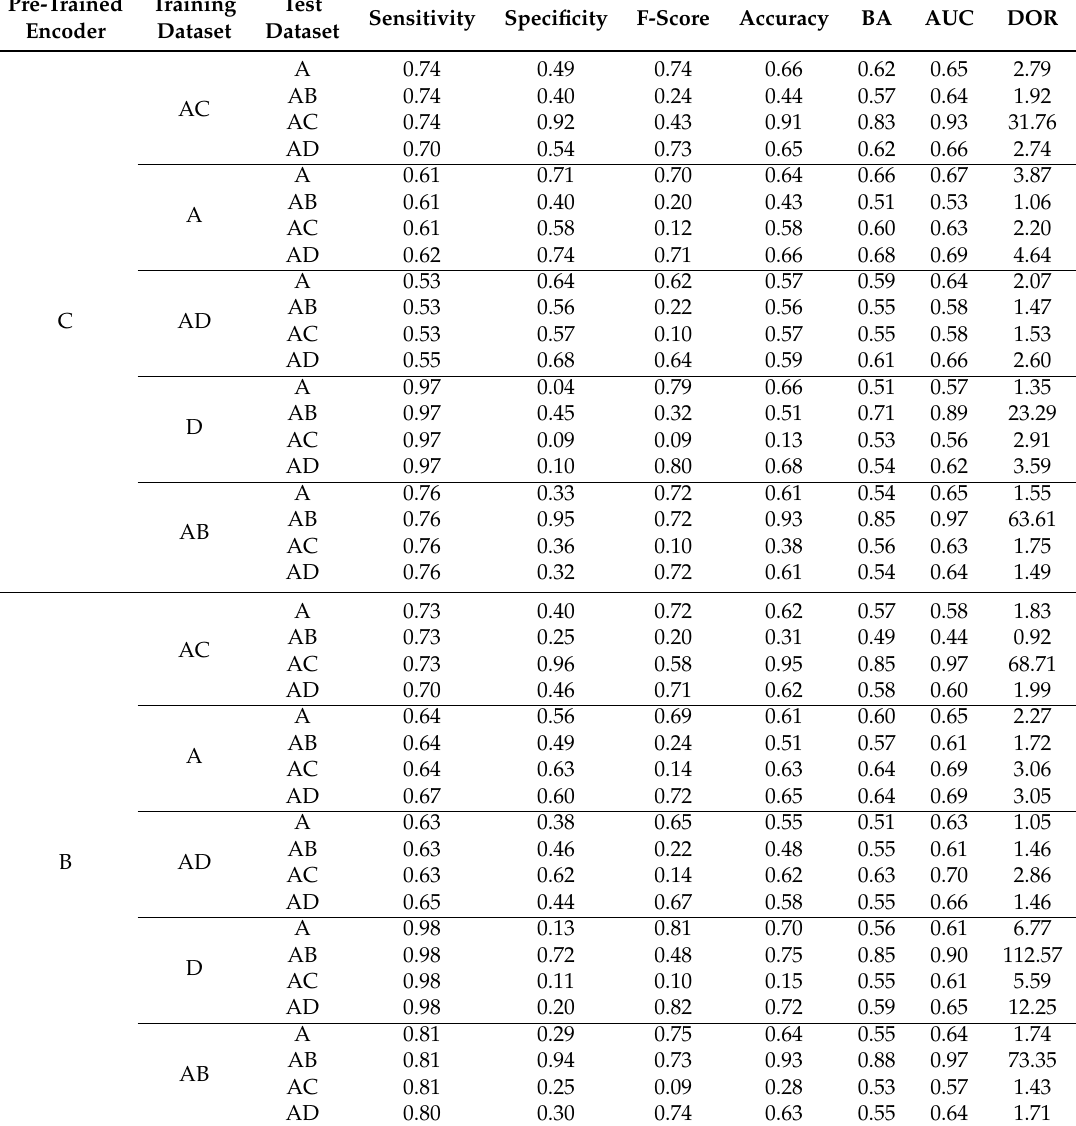
Table A3. Results obtained training a ResNet-50 model. Dataset naming follows Table 1.